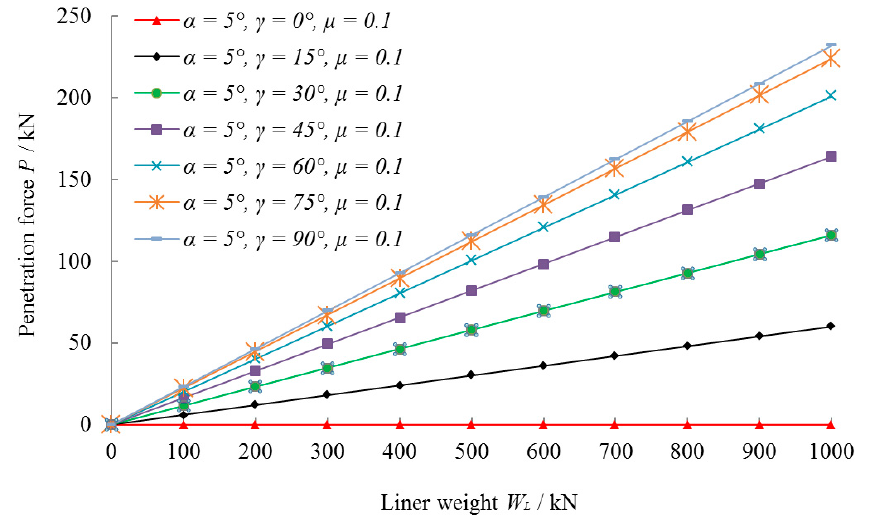
Figure 17. Relationship between penetration force P and liner weight W L .